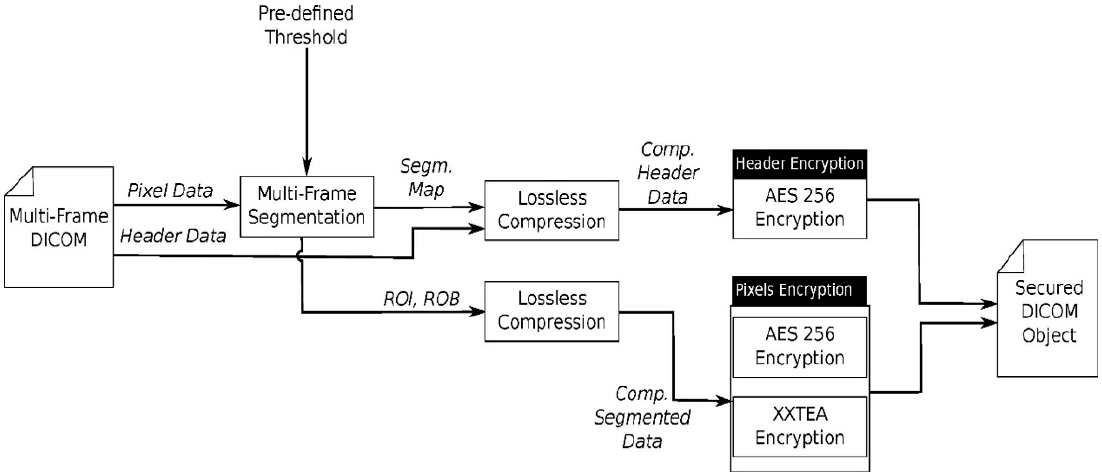
Figure 7. The proposed Holistic-Based SE approach.